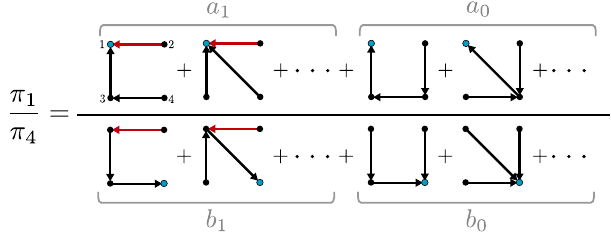
FIG. 10. Symmetric edge perturbation. Groupings of spanning trees used in the derivation of the symmetric edge perturbation bound for the ratio of observables π 1 = π 4 with perturbed edge parameter B 12 . Roots are labeled in blue, and affected rates are highlighted in